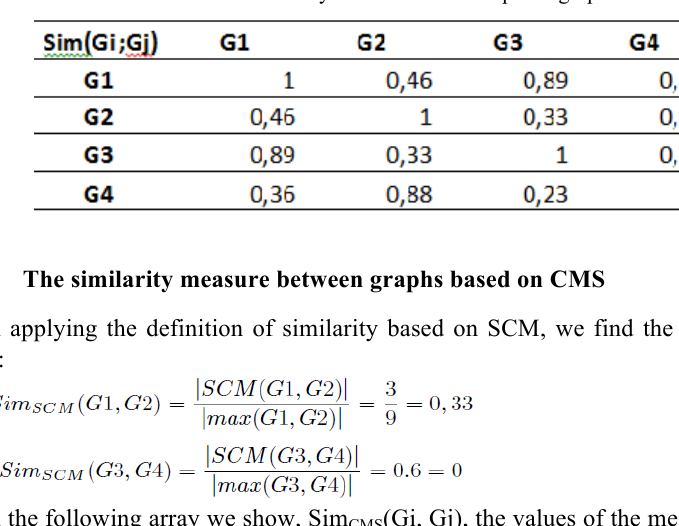
Table 3. Similarity between the concepts of graphs